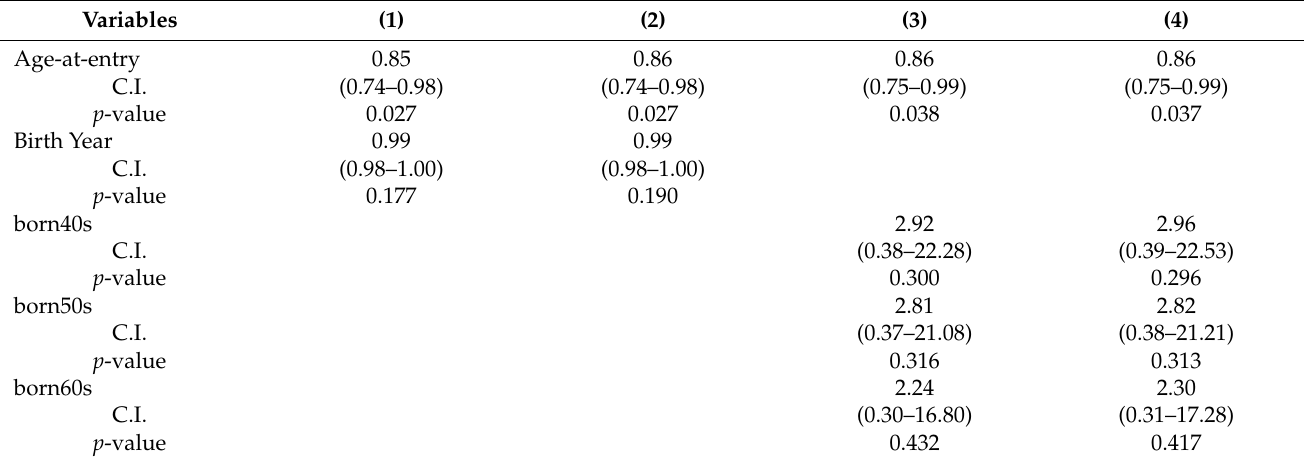
Table 2. Cox Regression Results with NFL Age-at-Entry